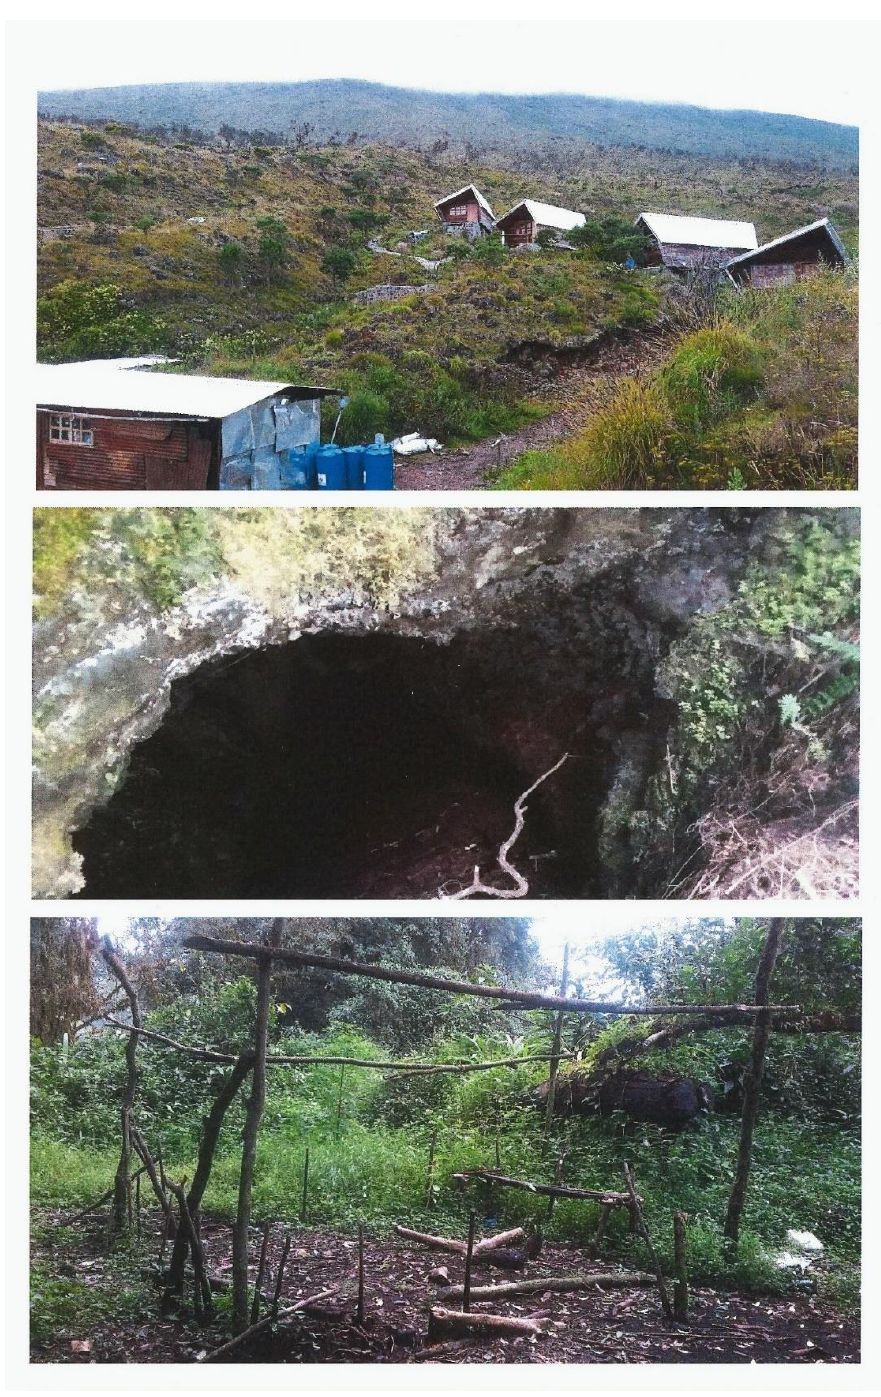
Figure 2. Land use on the MCNP comprising tourism development (top), an ancestral cave (middle), and a traditional camp (bottom).